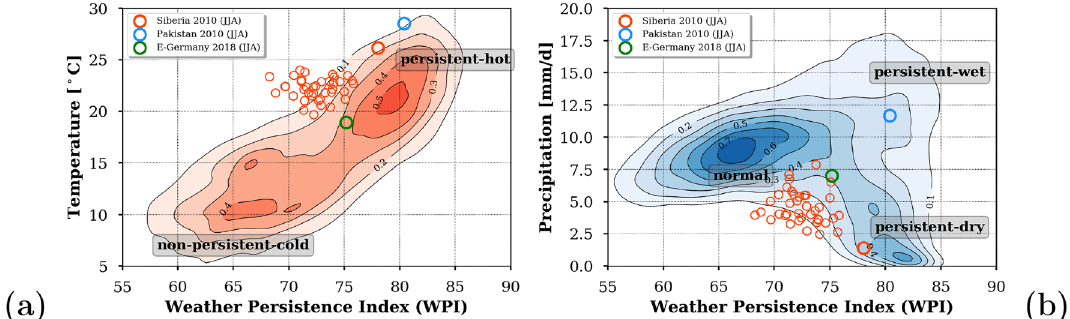
◦ ◦ N/50 E, ◦ ◦ N/12 E, green). Additionally, the